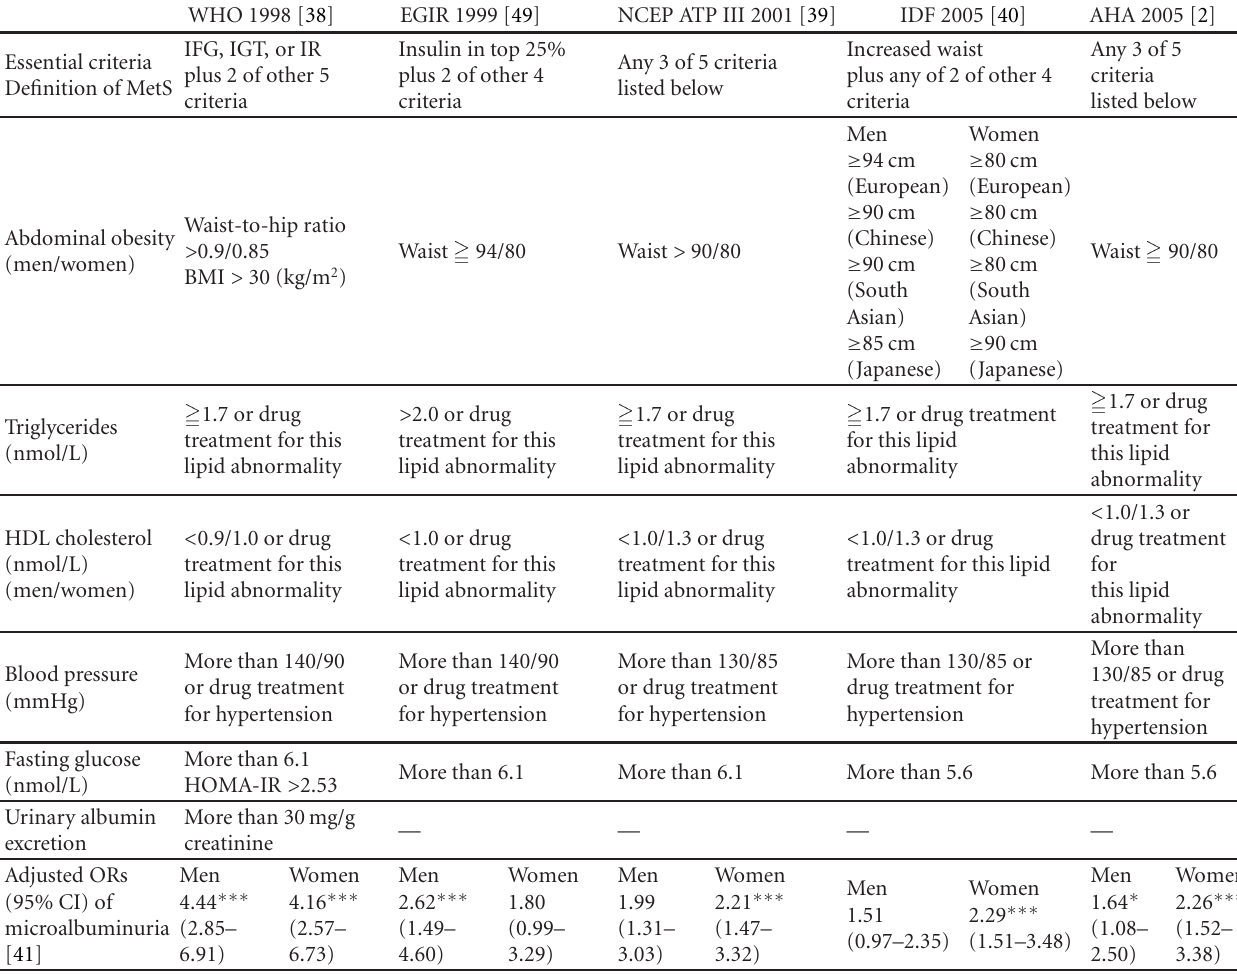
Table 2: Definitions of metabolic syndrome and adjusted ORs of associated